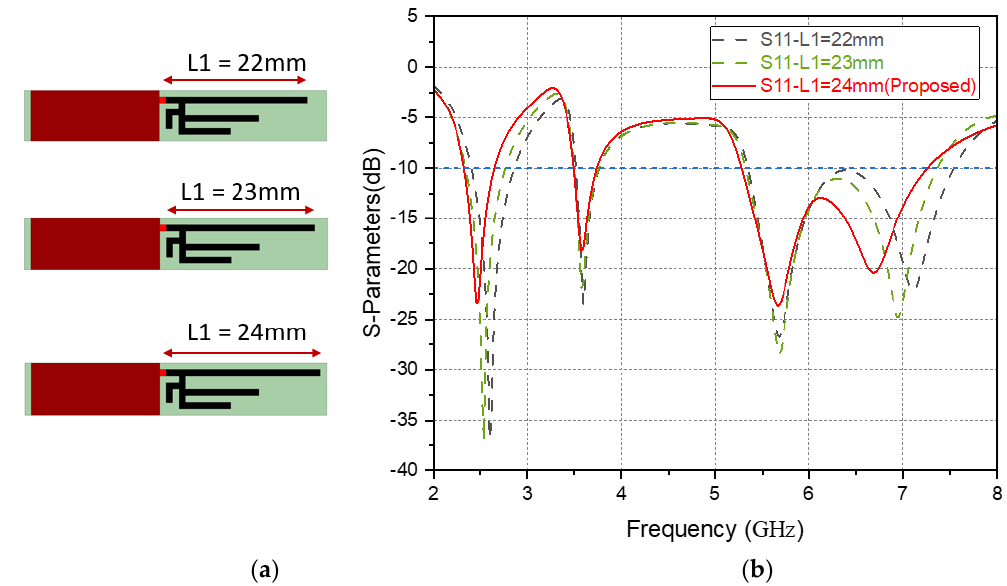
Figure 4. ( a ) Schematic diagram of L1 length variation of Ant. 1, ( b ) reflection coefficient (|S11|) of L1 length variation.